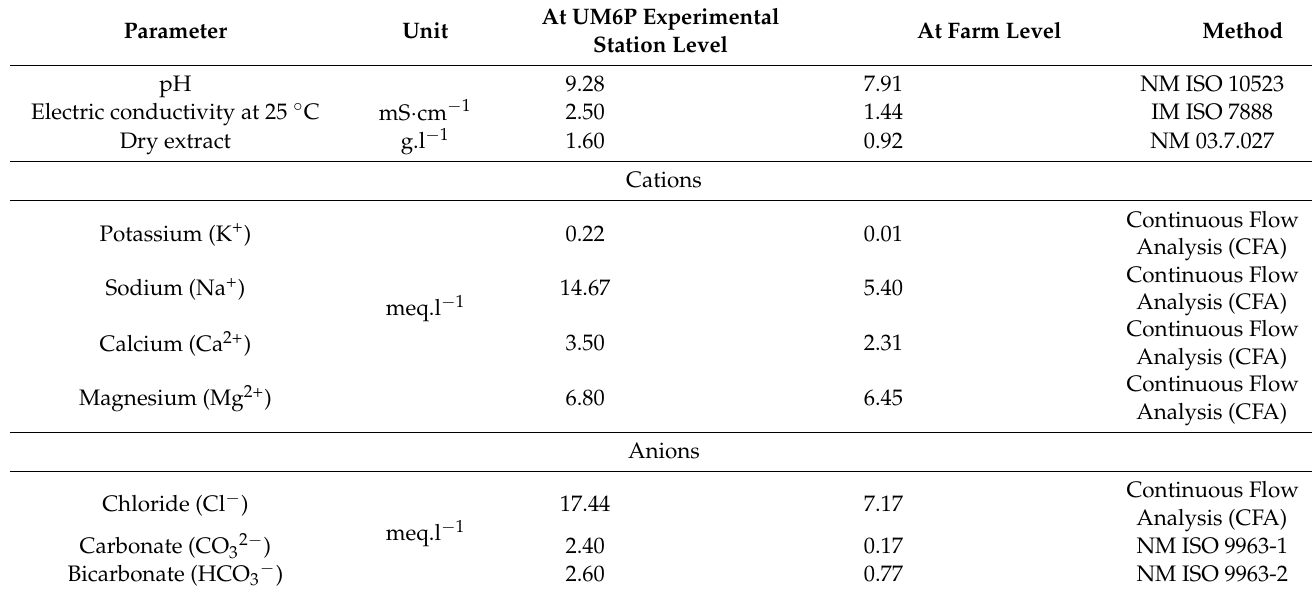
Table 12. Physicochemical analysis of irrigation water at the UM6P experimental station and farm